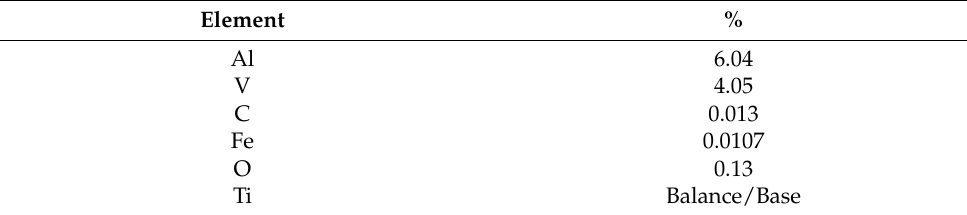
Figure 1. Non-prismatic part: ( a ) designed part; ( b ) a typical EBM part fabricated with across-layers orientation, ( c ) a typical EBM part fabricated with parallel layers orientation (Cross sections AA’ and BB’ used later.). Table 1. Chemical composition of powdered Ti6Al4V